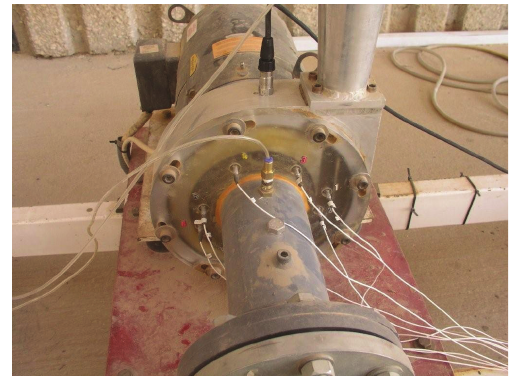
Figure 4: Measurements of pressure fluctuations: model